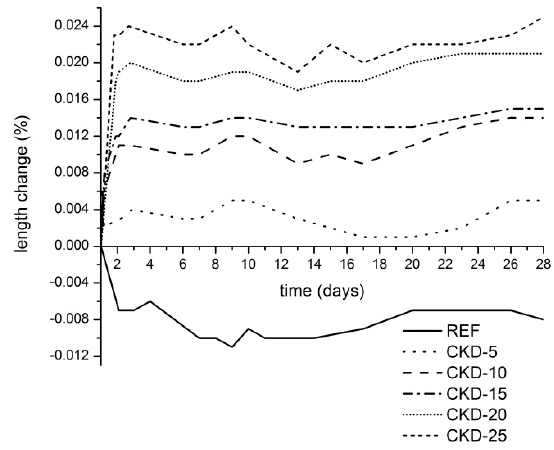
Figure 3. Length changes of alkali-activated mortars with different amounts of CKD during saturated (under water) curing.